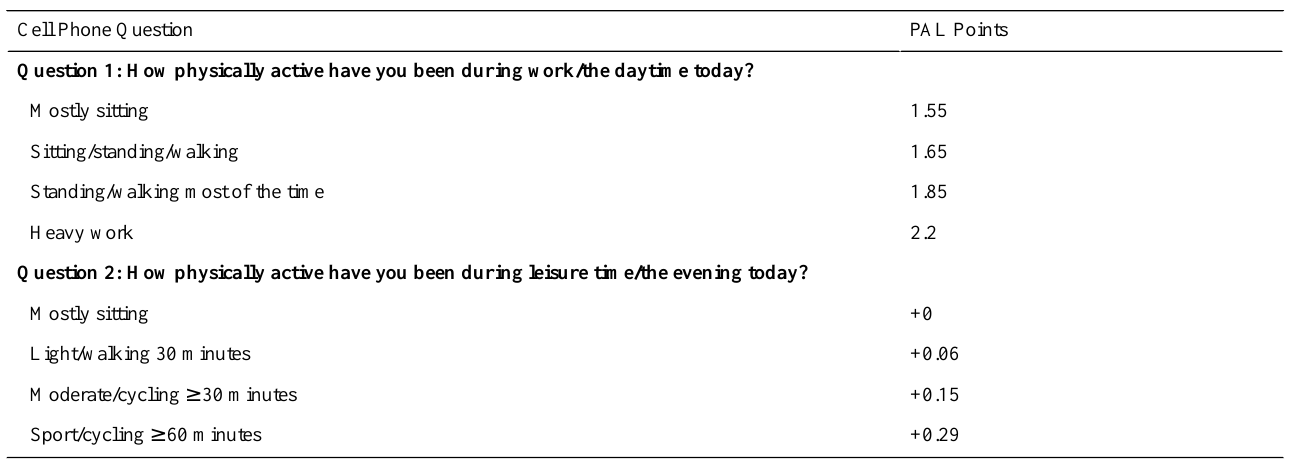
Table 1. The cell phone questionnaire consisting of two